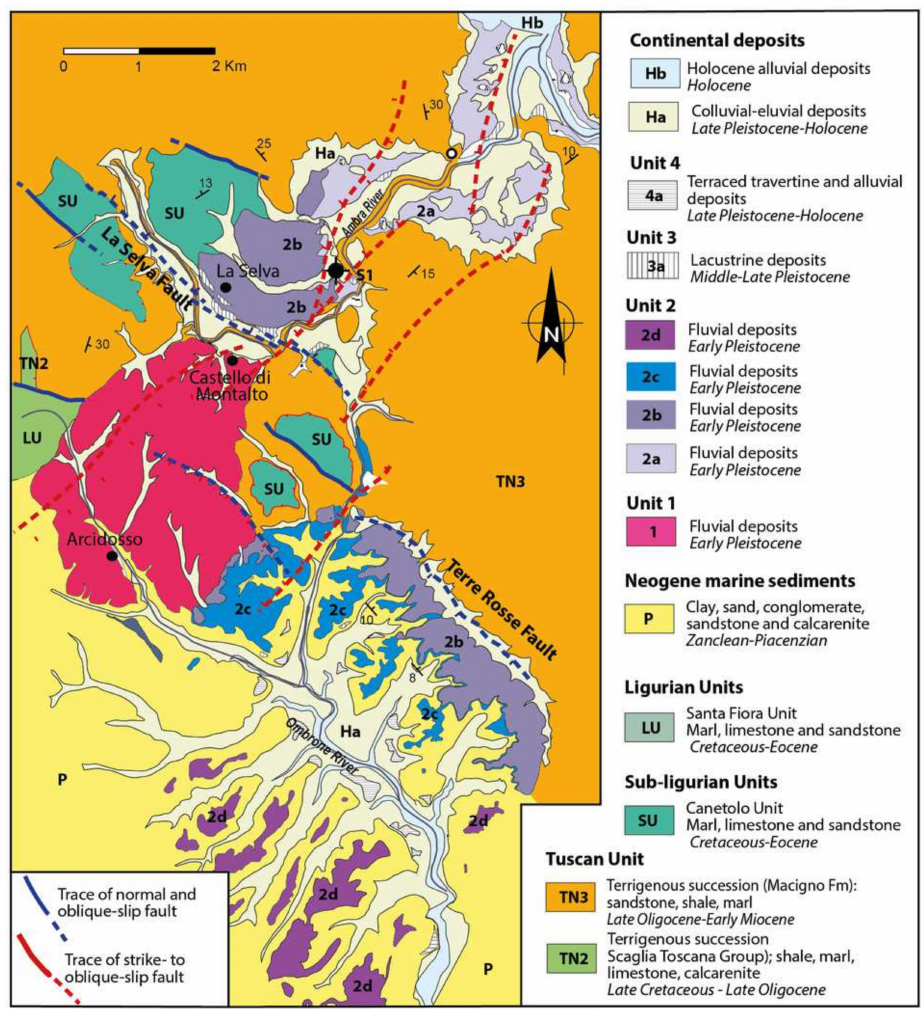
Figure 6. Geological map of the Ambra Valley (from [38], modified). La Selva Fault corresponds to the F1 mentioned in the text and indicated in Figures 2 and